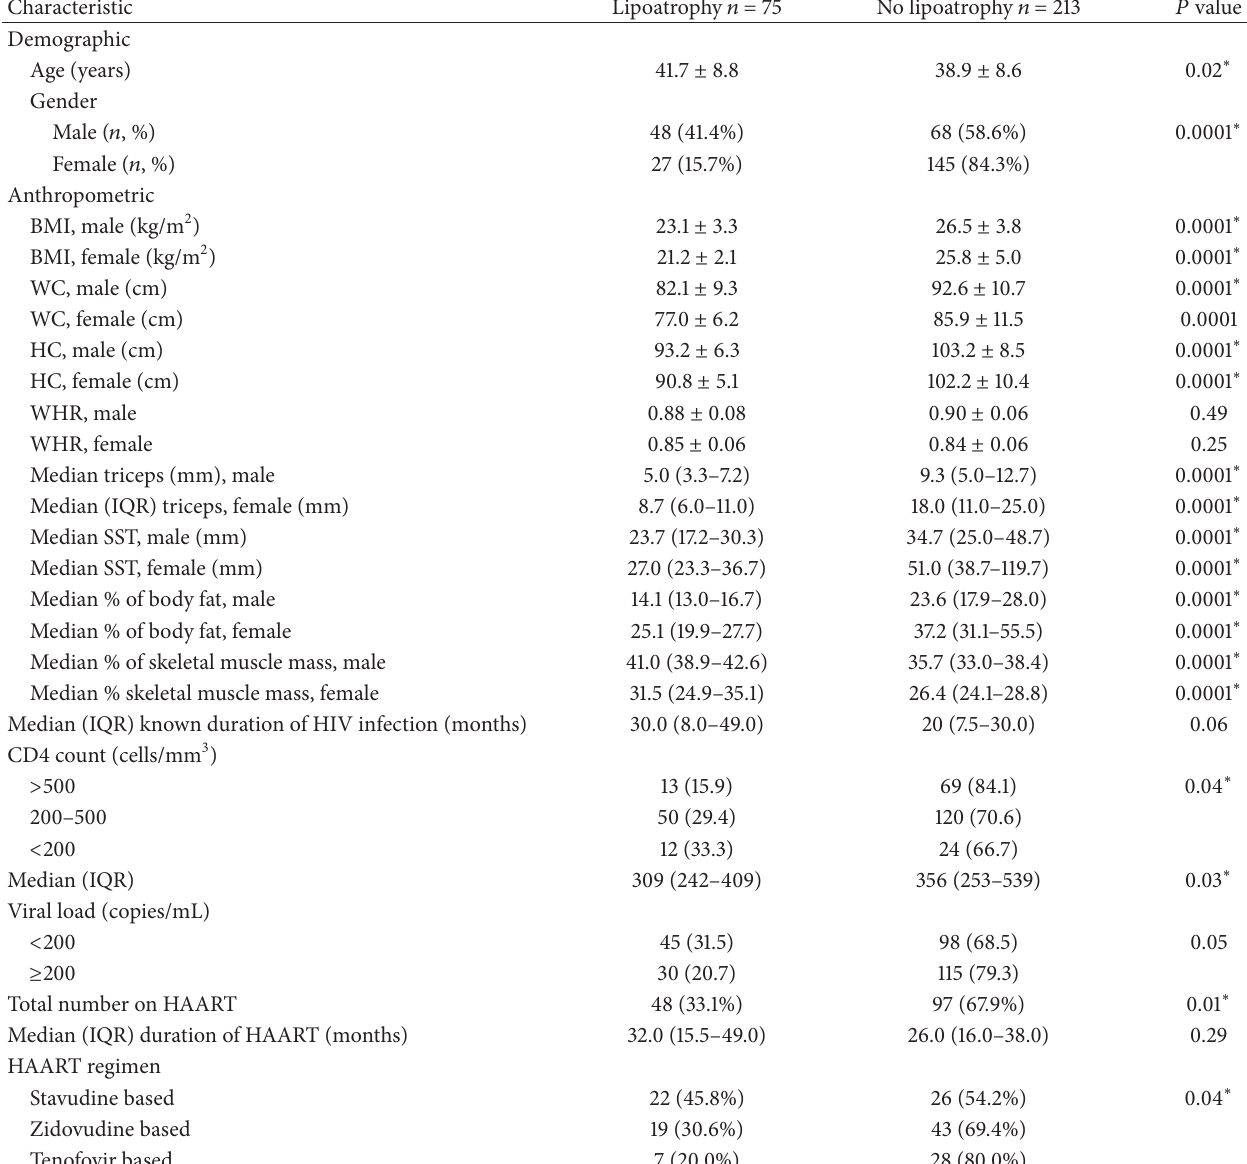
Table 4: Demographic, anthropometric, and body composition of lipoatrophy in the study